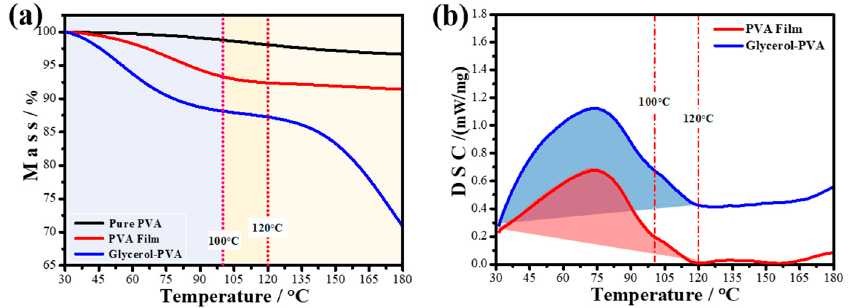
Figure 4. Simultaneous thermal analysis of PVA film with or without glycerol: ( a ) TG; ( b ) DSC.